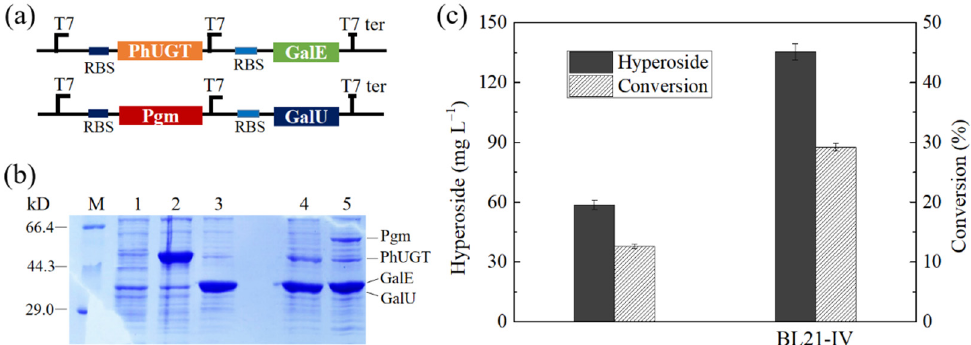
Figure 3 . The construction and performance of BL21-IV. ( a ) The construction of BL21-IV harboring pETDuet-PhUGT-GalE with PhUGT and GalE, and pACYCDuet-Pgm-GalU with Pgm and GalU. ( b ) SDS-PAGE analysis of BL21-IV. M, Marker; Lane 1, BL21(DE3) with pET28a; Lane 2, BL21(DE3) with pET28a-PhUGT; Lane 3, BL21(DE3) with pET28a-GalE; Lane 4, BL21(DE3) with pETDuet-PhUGT-GalE; Lane 5, BL21(DE3) with pACYCDuet-Pgm-GalU. ( c ) The production of hyperoside in initial fermentation medium M-1 with 302.2 mg·L − 1 quercetin.